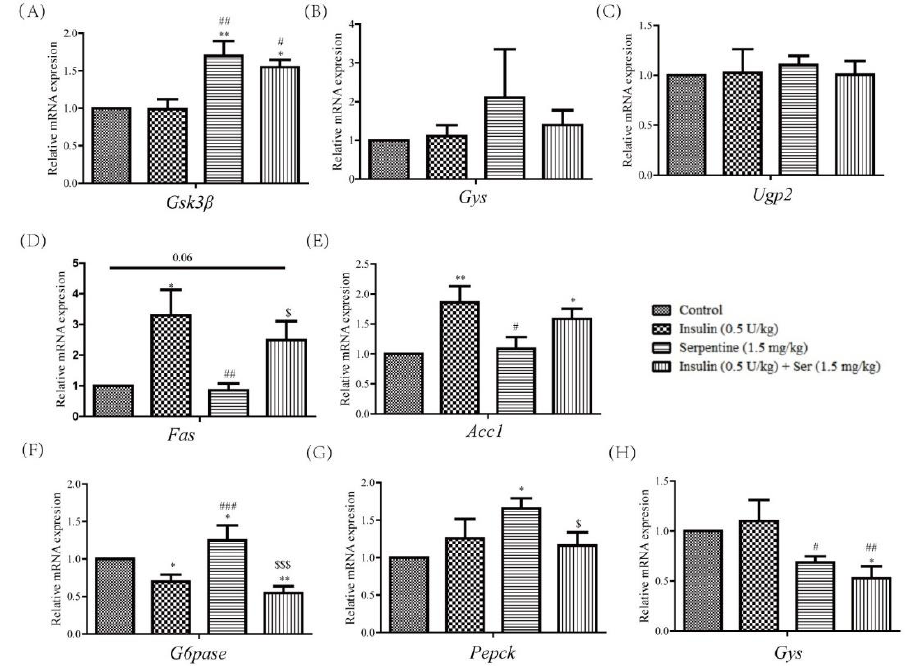
Figure 5. Effects of serpentine and insulin treatment on genes related to gluconeogenesis, glycogen synthesis, and fat synthesis. mRNA levels of glycogen synthesis-related genes ( A ) Gsk3 β , ( B ) Gys and ( C ) Ugp2 in muscle tissue. mRNA levels of fat synthesis-related genes ( D ) Fas and ( E ) Acc1 in subcutaneous adipose tissue. mRNA levels of gluconeogenesis and glycogen synthesis-related genes ( F ) G6Pase , ( G ) Pepck, and ( H ) Gys in liver tissue. Data are expressed as mean ± SEM ( n = 8 per group). * p < 0.05, ** p < 0.01 versus control; # p < 0.05, ## p < 0.01, ### p < 0.001 versus insulin (0.5 U/kg); $ p < 0.05, $$$ p < 0.001 versus serpentine (1.5 mg/kg).